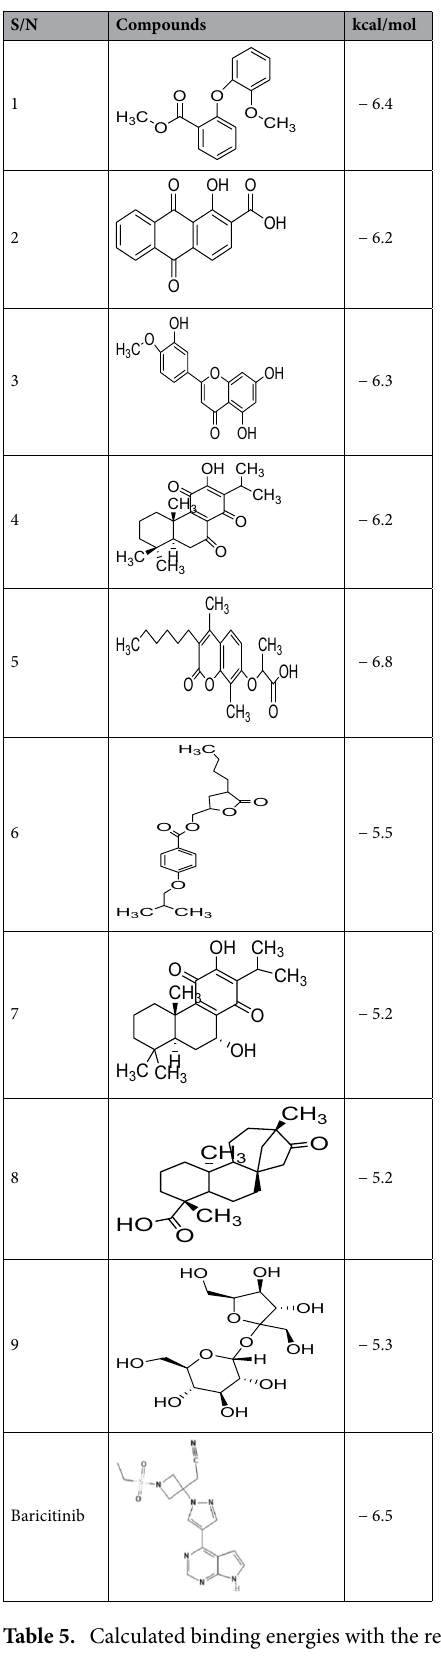
Table 5. Calculated binding energies with the respective targets obtained from AutoDock